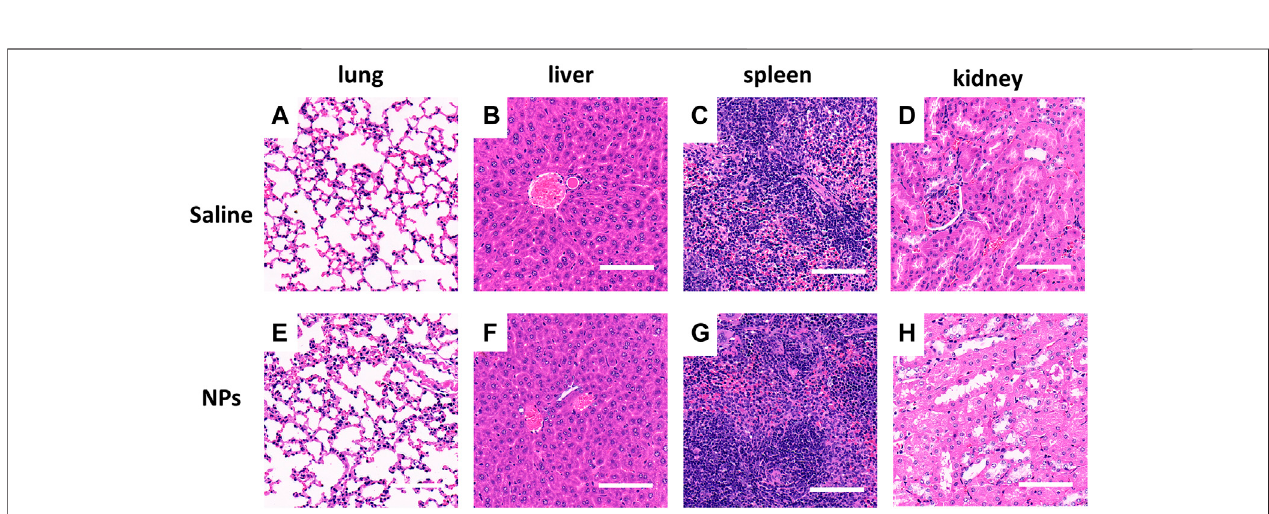
FIGURE 7 | Nanoparticles showed no organ toxicity after local intra-tumor injection. (A – D) Microscopic photos of H&E staining of organs (lung, liver, spleen, and kidney) in the saline injection group. (E – H) Microscopic photos of H&E staining of organs (lung, liver, spleen, and kidney) in the nanoparticle injection group. Scale bar = 200 μ